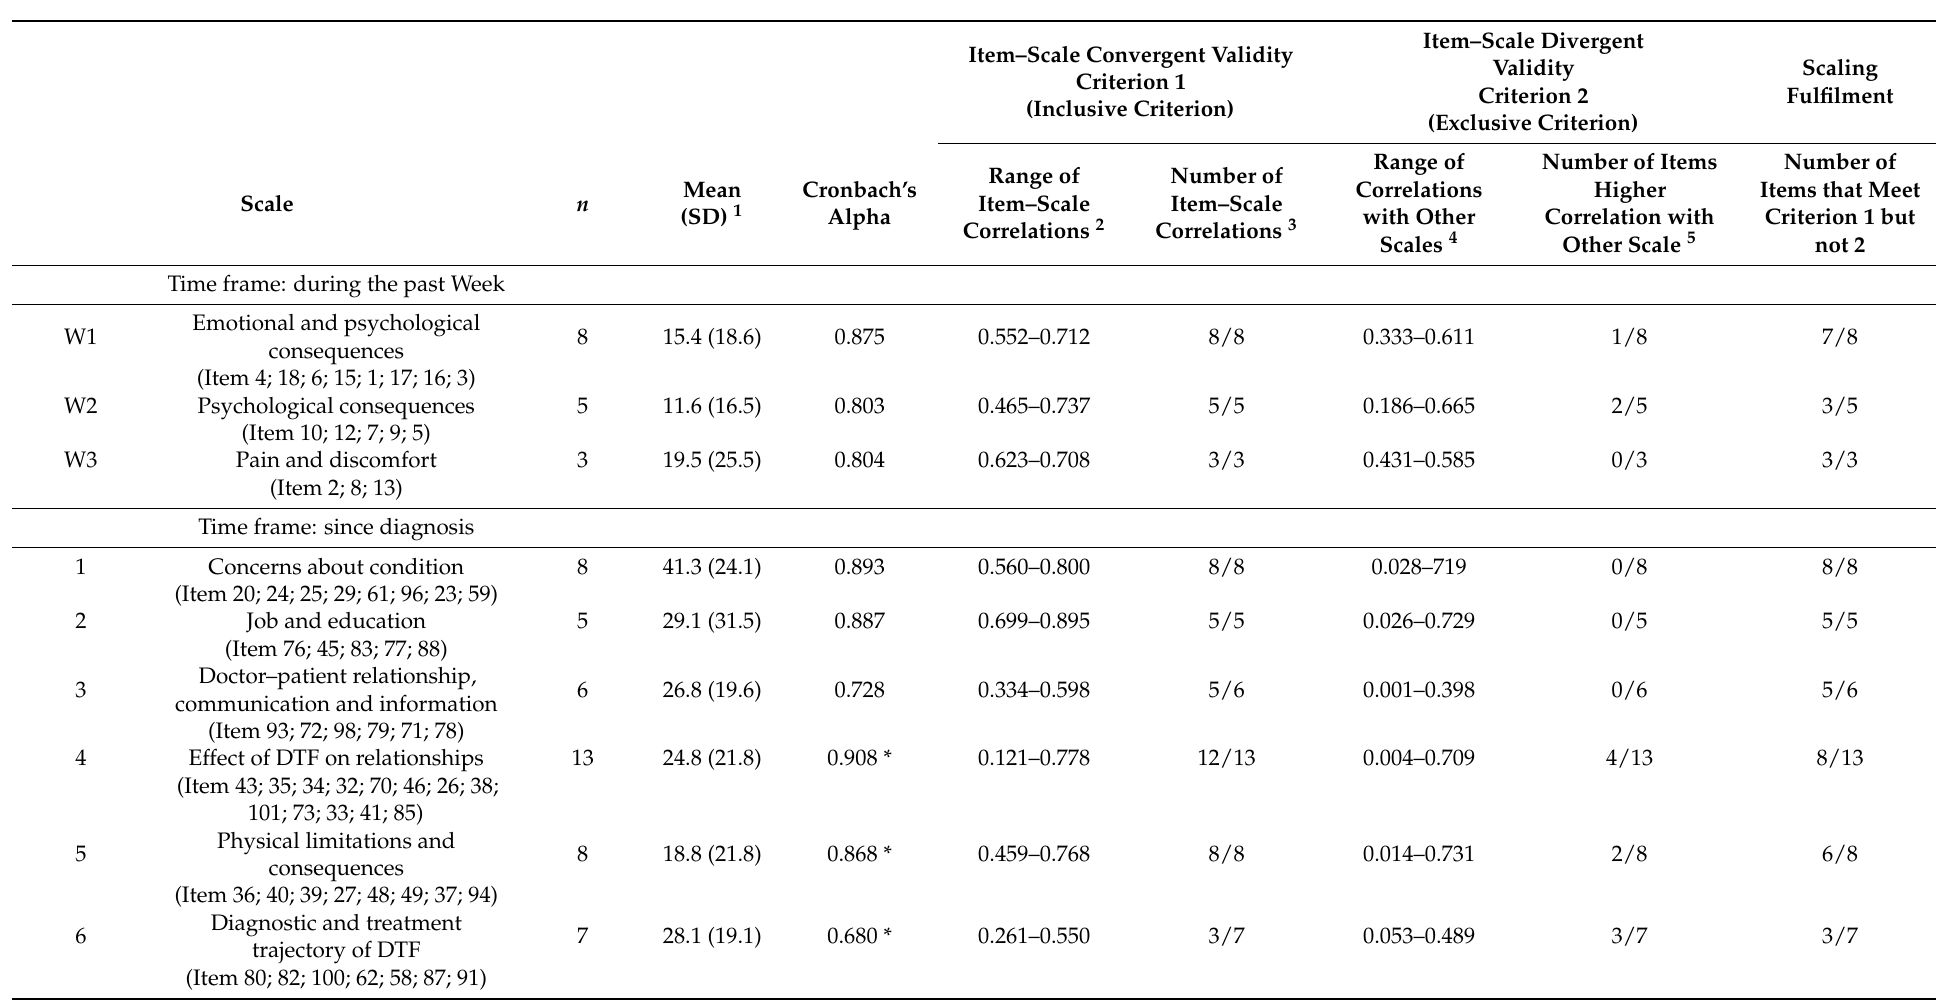
Table 5. Summary of results of multi-trait